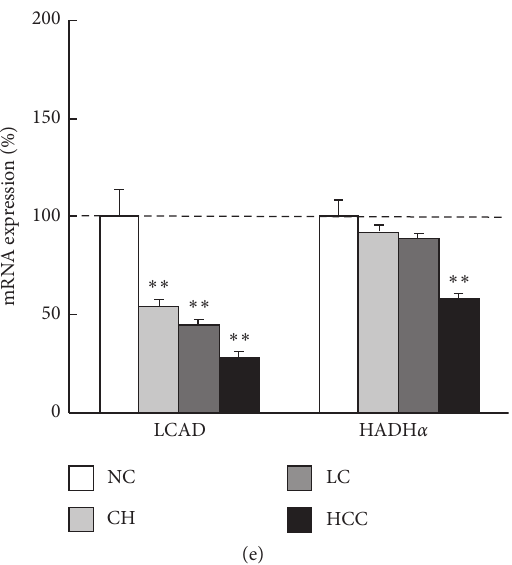
Figure 2: Metabolic gene expressions in each liver disease sate in human liver samples. Quantitative RT-PCR analysis of metabolic genes related to (a) glycolysis, (b) TCA cycle, (c) FA synthesis and uptake, (d) TG synthesis, and (e) β -oxidation, by liver disease states. The gene expression levels normalized to those of normal control tissues were presented as mean ± SE. ∗ p < 0 . 05 and ∗ ∗ p < 0 . 01 vs. normal control tissue. NC, normal control; CH, chronic hepatitis; LC, liver cirrhosis; HCC, hepatocellular carcinoma; G6PD, glucose-6-phosphate de- hydrogenase; PK, pyruvate kinase; PDH, pyruvate dehydrogenase; ACO, aconitase; FAS, fatty acid synthase; PPAR, peroxisome pro- liferator-activated receptor; DGAT, diacylglycerol acyltransferase; LCAD, long chain acyl-coenzyme A dehydrogenase; HADH, hydroxyacyl-coenzyme A